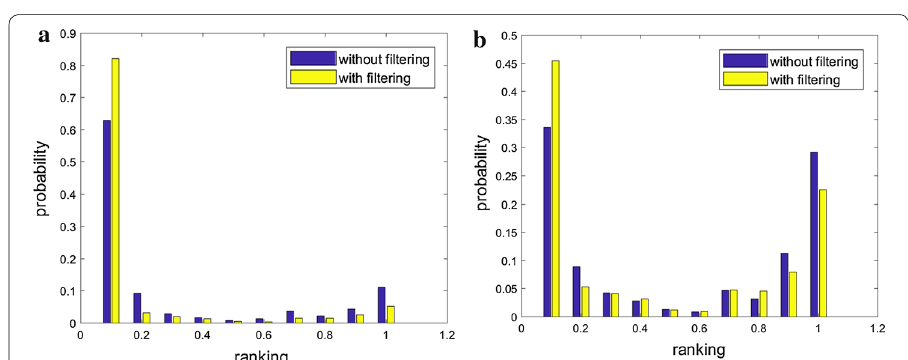
Fig. 2 Actual ranking distribution for testing labels with label 0 and 1 respectively (Decision Tree classifier, German